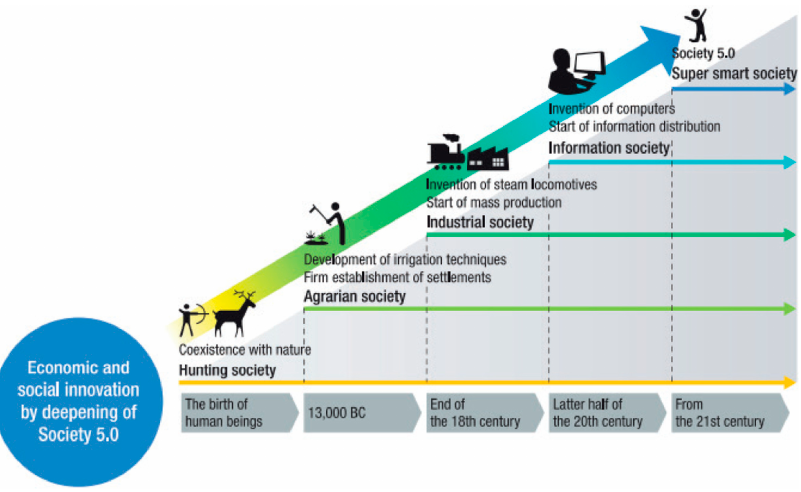
Figure 13. The Evolution of Society 5.0 (Reprinted from Ref. [124]).